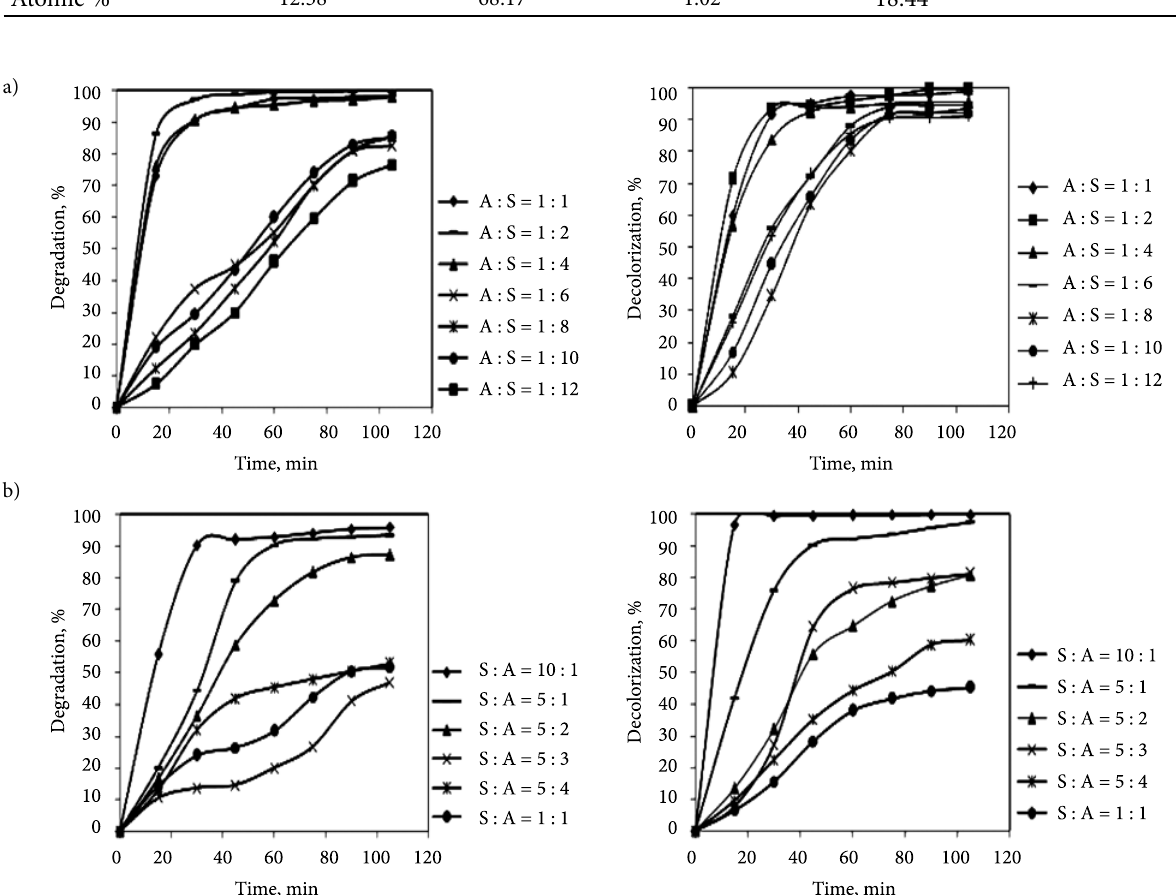
Fig. 10. Percentage degradation and decolourization of RB5 at a) different FA to FS ratio b) different FS to FA ratio